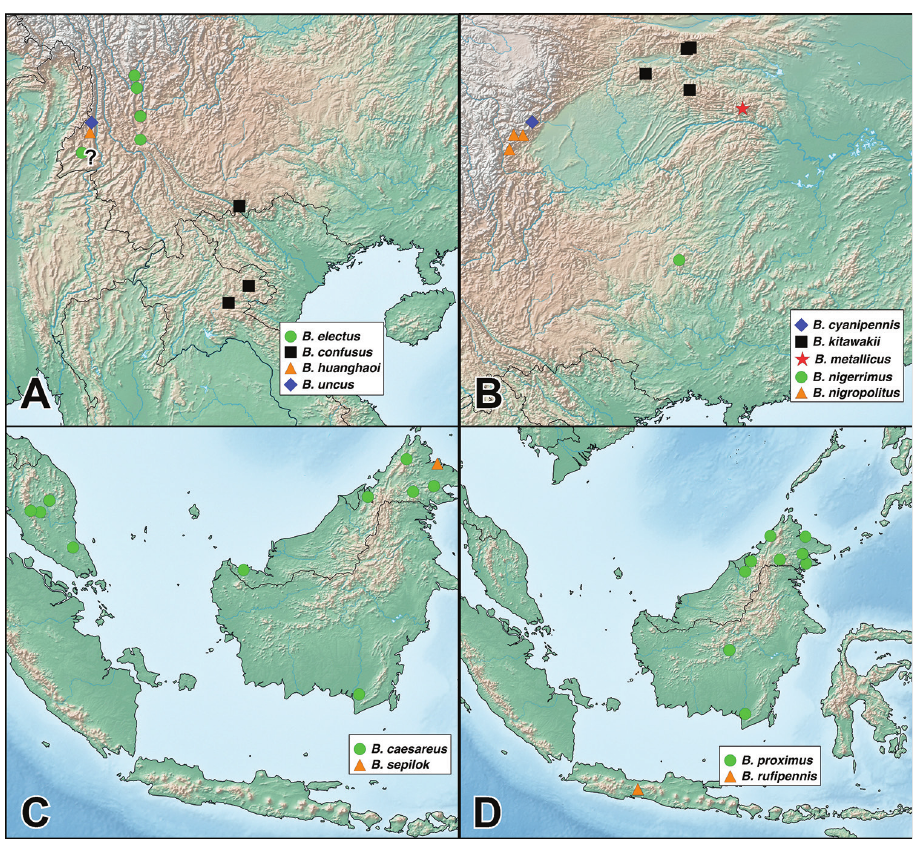
Figure 19. Distribution of: Bolitogyrus electus Smetana & Zheng, B. confusus Brunke, B. huanghaoi Hu et al., and B. uncus Cai et al. ( A ); B. cyanipennis (Zheng), B. kitawakii Smetana & Zheng, B. metallicus Cai et al., B. nigerrimus Yuan et al., and B. nigropolitus Smetana ( B ); B. caesareus (Bernhauer) and B. sepilok Brunke ( C ); B. proximus (Cameron) and B. rufipennis (Cameron) ( D